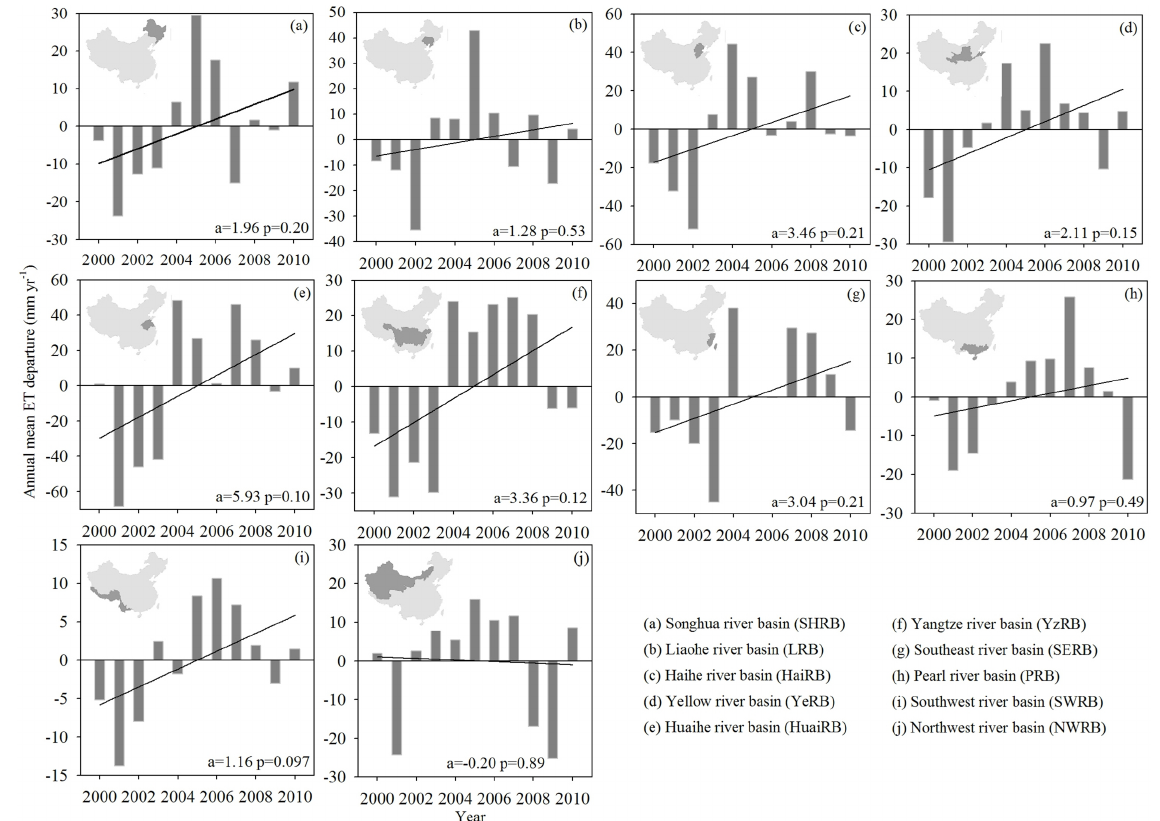
Fig. 9. Departures of annual ET from multi-year means in 10 basins from 2000 to 2010.